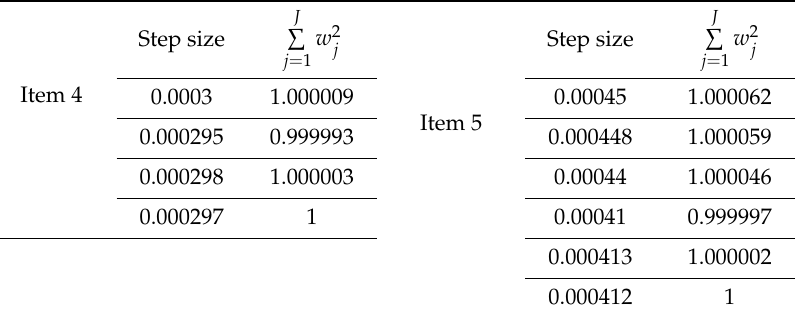
Table 4. Tuning the step size to reach a feasible